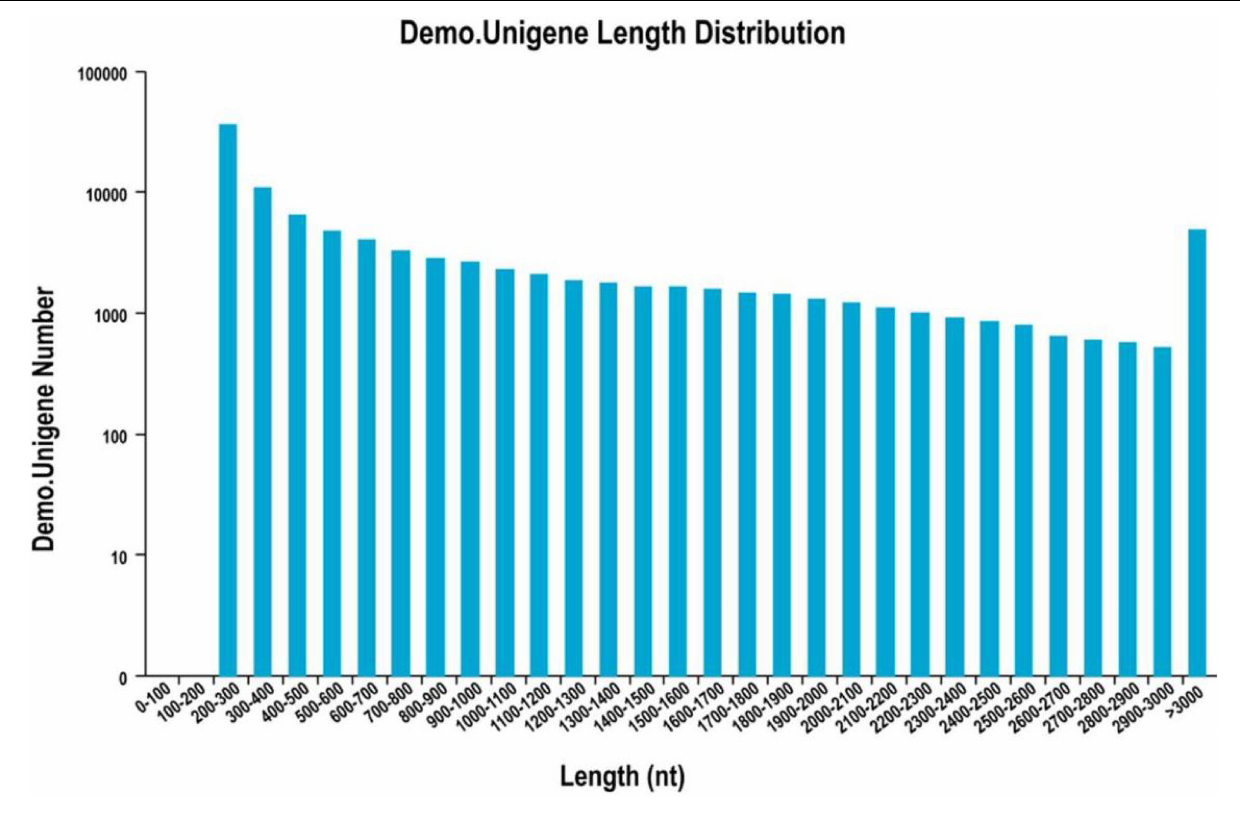
FIGURE 2 | Unigene length distribution map.